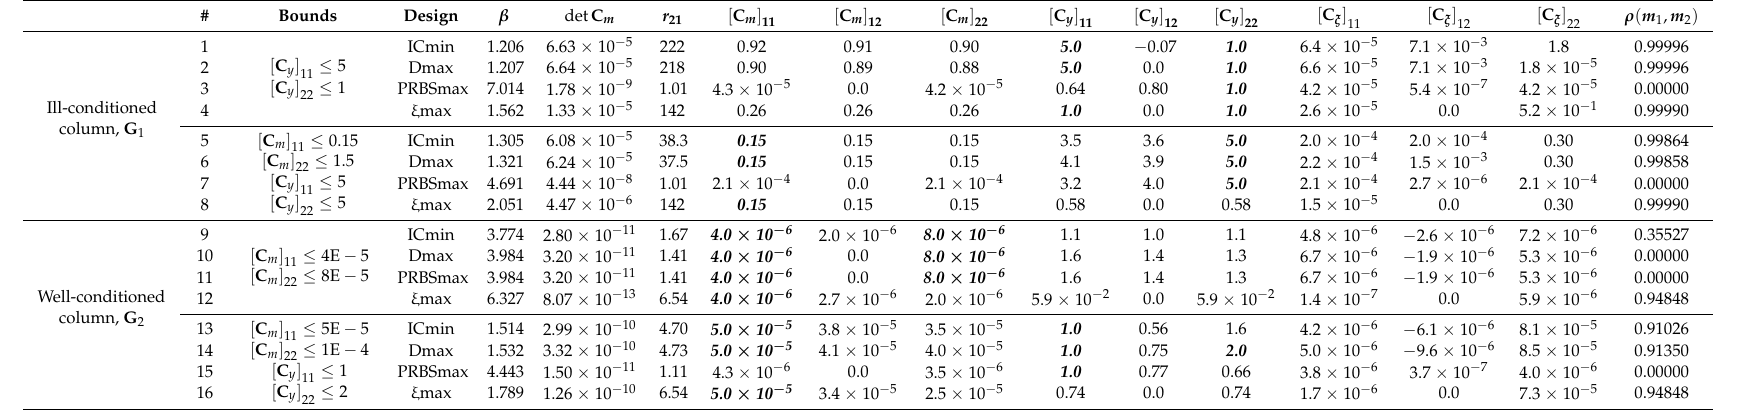
(cid:112) (cid:112) var ( ξ 2 ) / var ( ξ 1 ) ; β : Equation